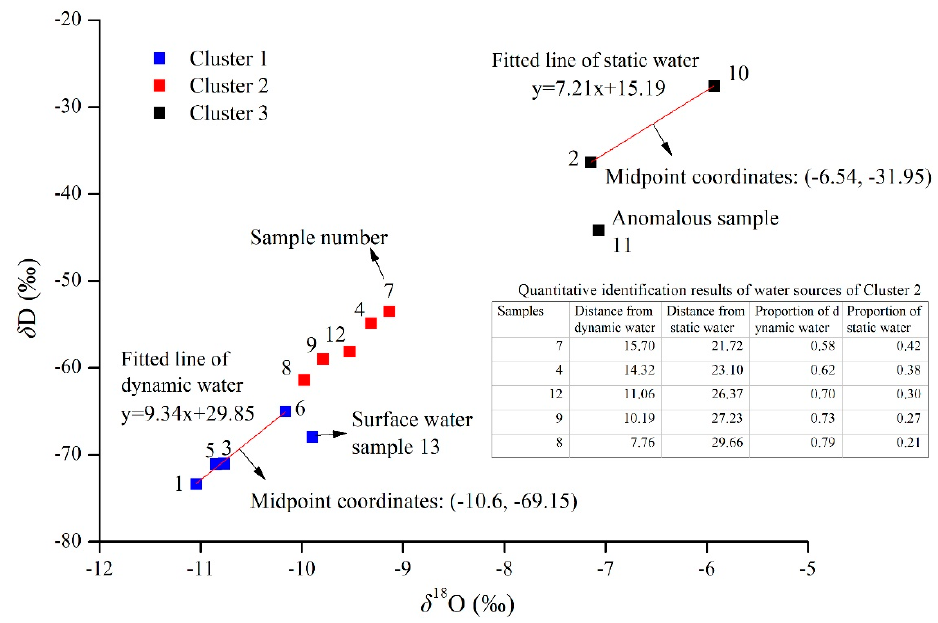
Figure 11. Quantitative identification of the produced water sources between dynamic water and static water. static